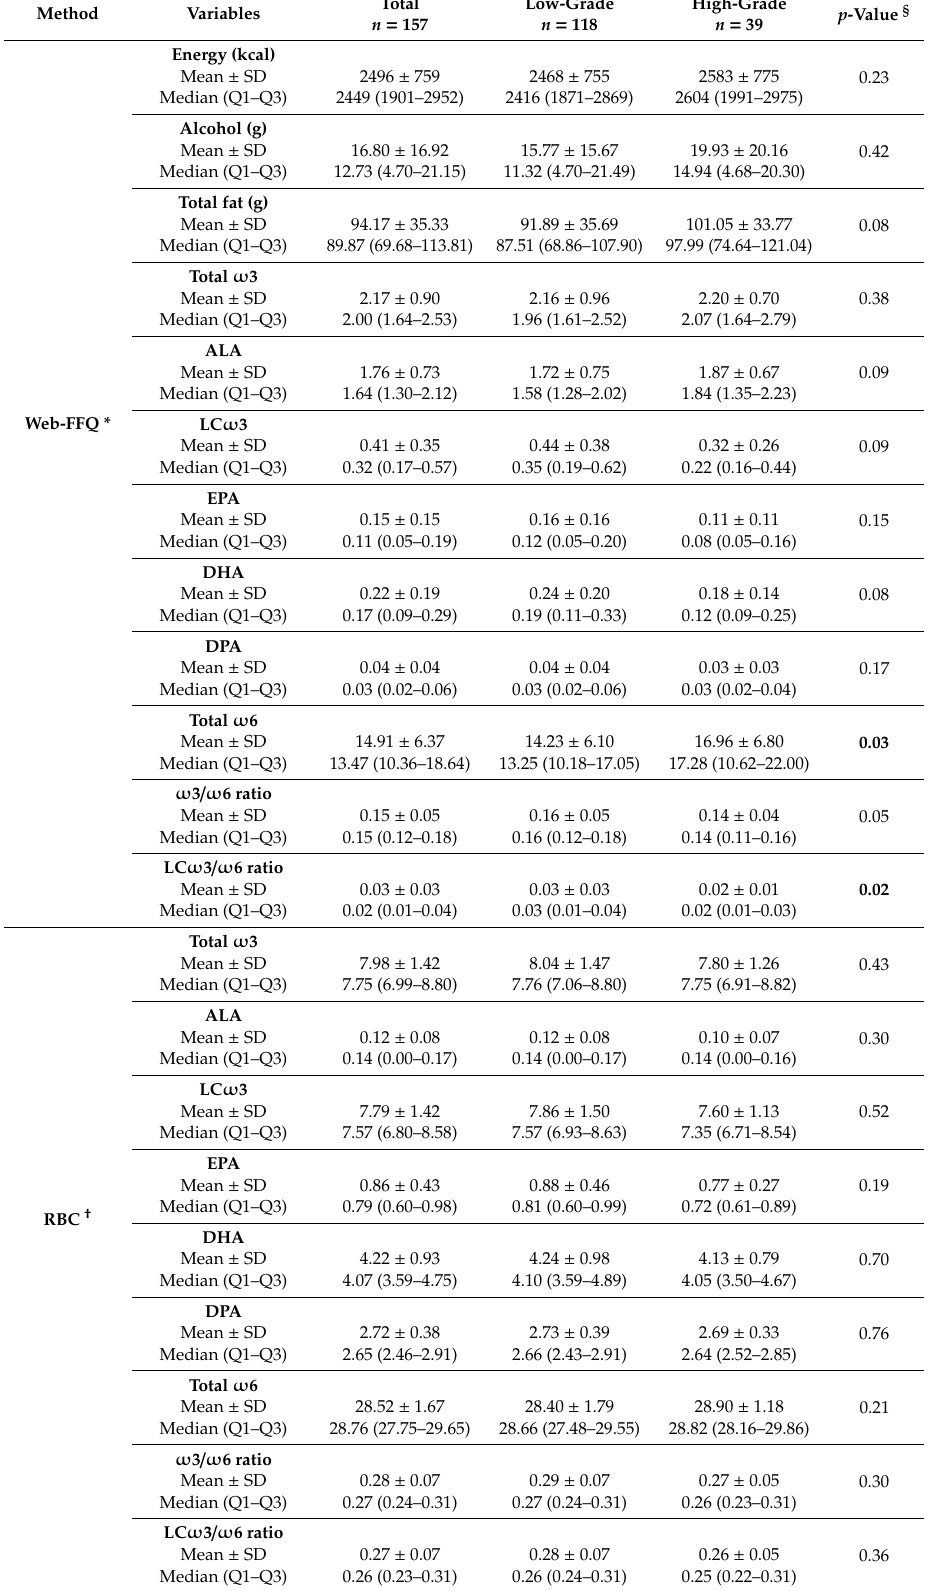
Table 2. Fatty acid intake, fatty acid profiles of RBC membranes, and of prostate tissue stratified by prostate cancer